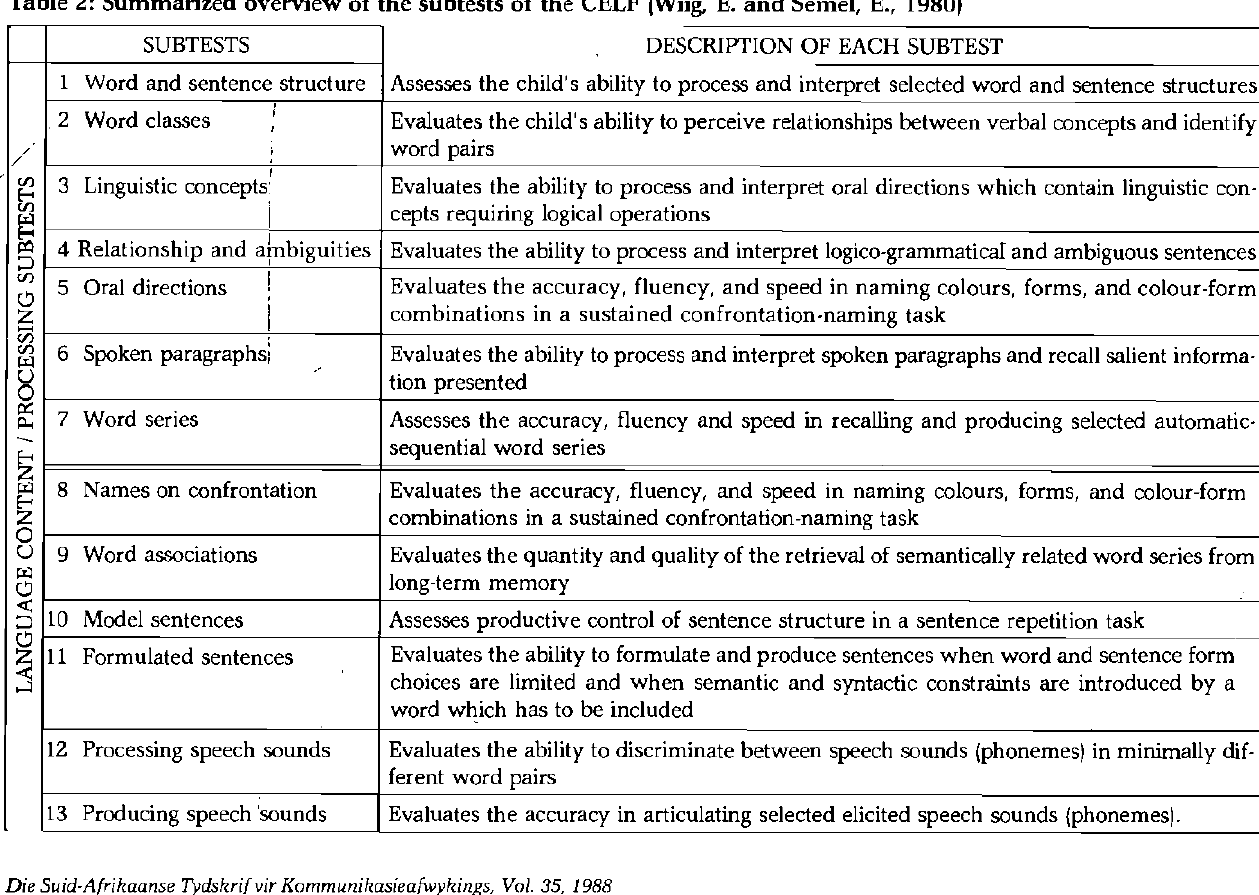
9 Word associations 10 Model sentences